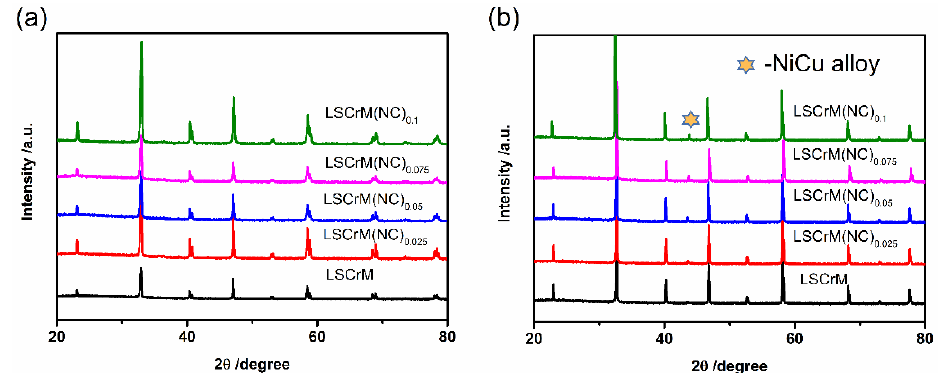
Figure 1. XRD characterization of LSCrM(NC) x samples. ( a ) Unreduced and ( b ) reduced samples.